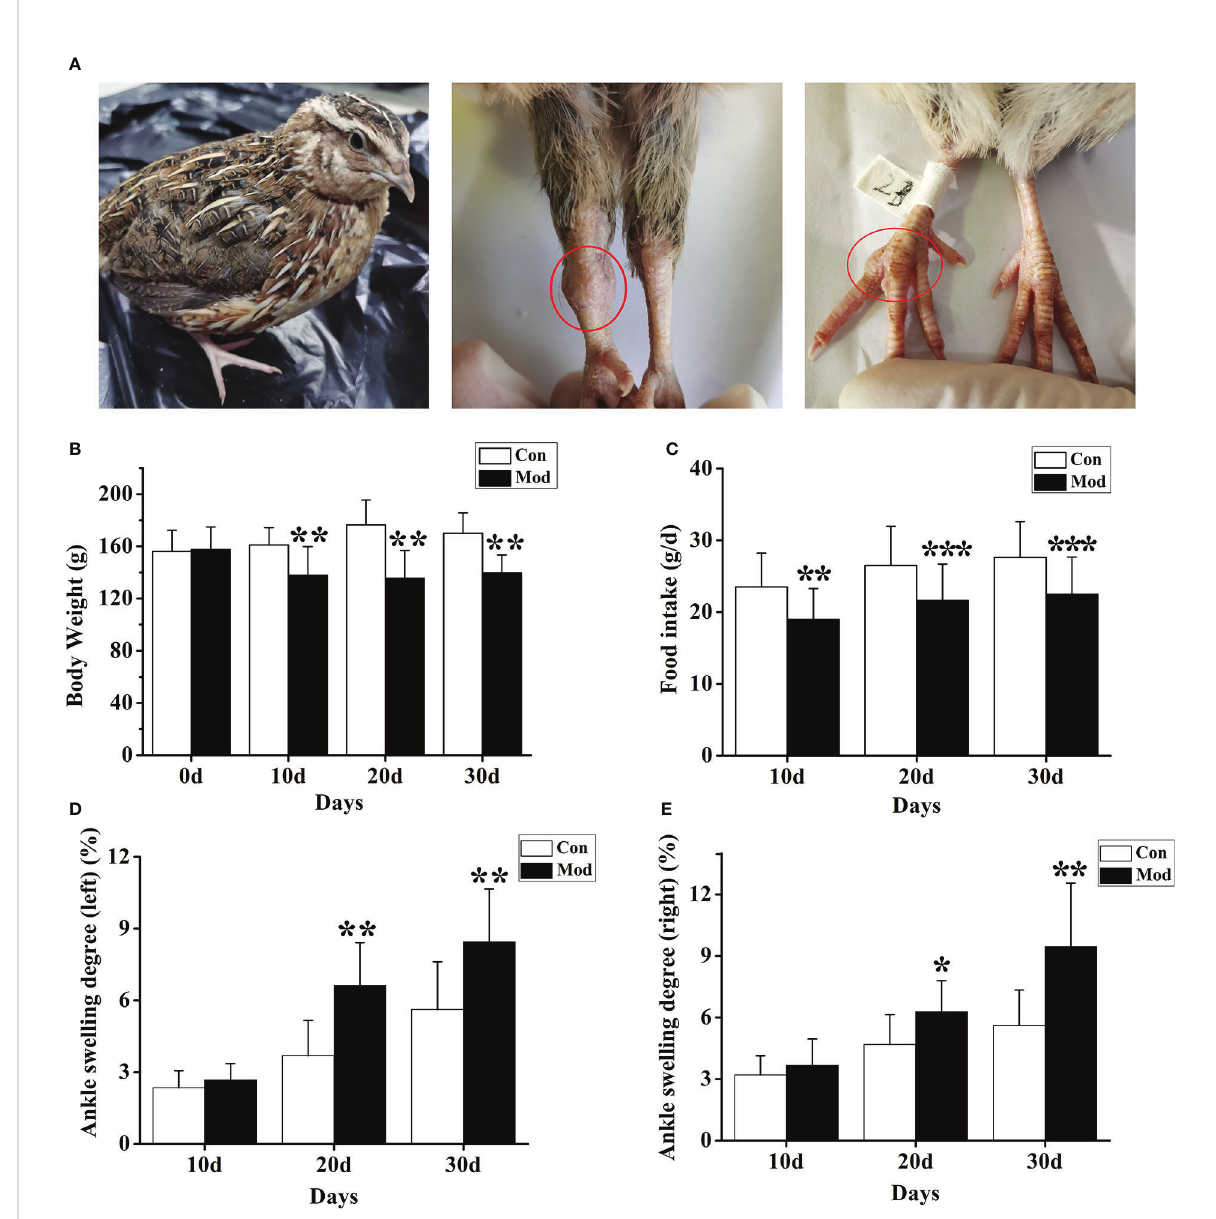
FIGURE 1 The general state of quail in the modeling process. (A) Swelling degree of quail joints in Mod group. (B) The body weight of quails in each group at different experimental stages. (C) The food intake of quail in each group at different experimental stages. The left (D) and right (E) of the swelling degree of the quail ankle joint during the experiment. Data are expressed as mean ± SEM for 8 quails in each group. * P < 0.05, ** P < 0.01 and *** P < 0.001 versus Con